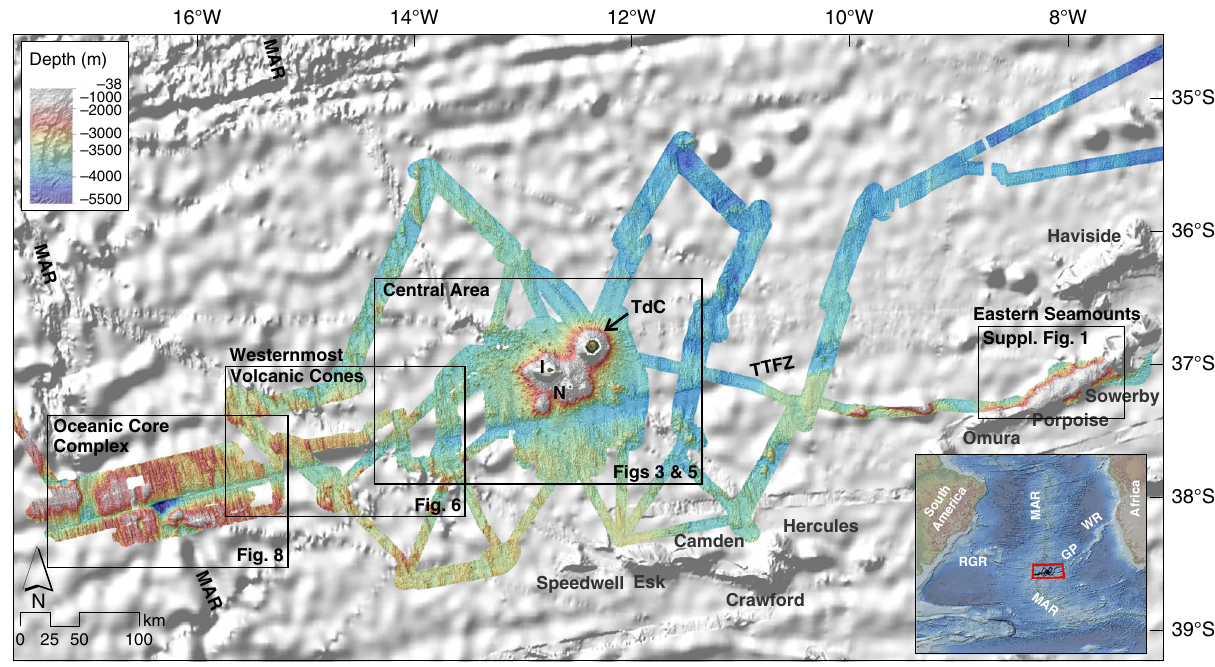
Fig. 2 Overview around Tristan da Cunha and fracture zone. Regional overview of new multibeam echosounder bathymetry in the vicinity of Tristan da Cunha and along the Tristan da Cunha transform fault and fracture zone system. Compilation includes data from NGDC 69 and UKHO 70 . The hillshade is illuminated by an azimuth of 315°. Boxes indicate regions shown in more detail in Figs. 3 – 7. The maps for the eastern seamounts are shown in Supplementary Fig. 1. Seabed backscatter maps are shown in Supplementary Fig. 2. GP Guyot Province; I Inaccessible Island; N Nightingale Island; MAR Mid-Atlantic Ridge; RGR Rio Grande Rise; TdC Tristan da Cunha; TTFZ Tristan da Cunha Transform Fault And Fracture Zone System; WR Walvis